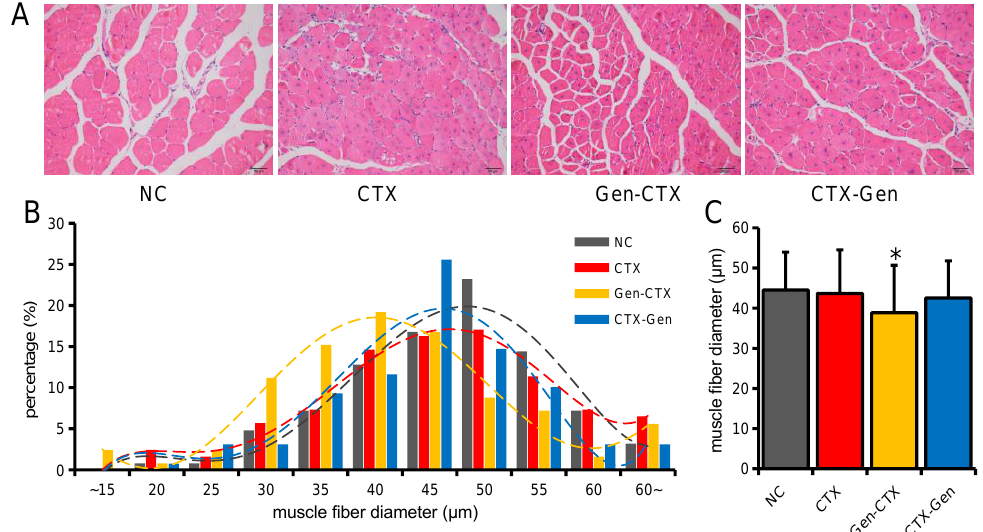
Figure 6. Effects of different treatment time of GEN on skeletal muscle regeneration. ( A ) HE staining of TA muscle of mice 21 days after injury. ( B ) Distribution frequency of TA muscle fiber diameter. ( C ) Mean muscle fiber diameter of TA muscle. n = 3. * p < 0.05, compared with the NC group.